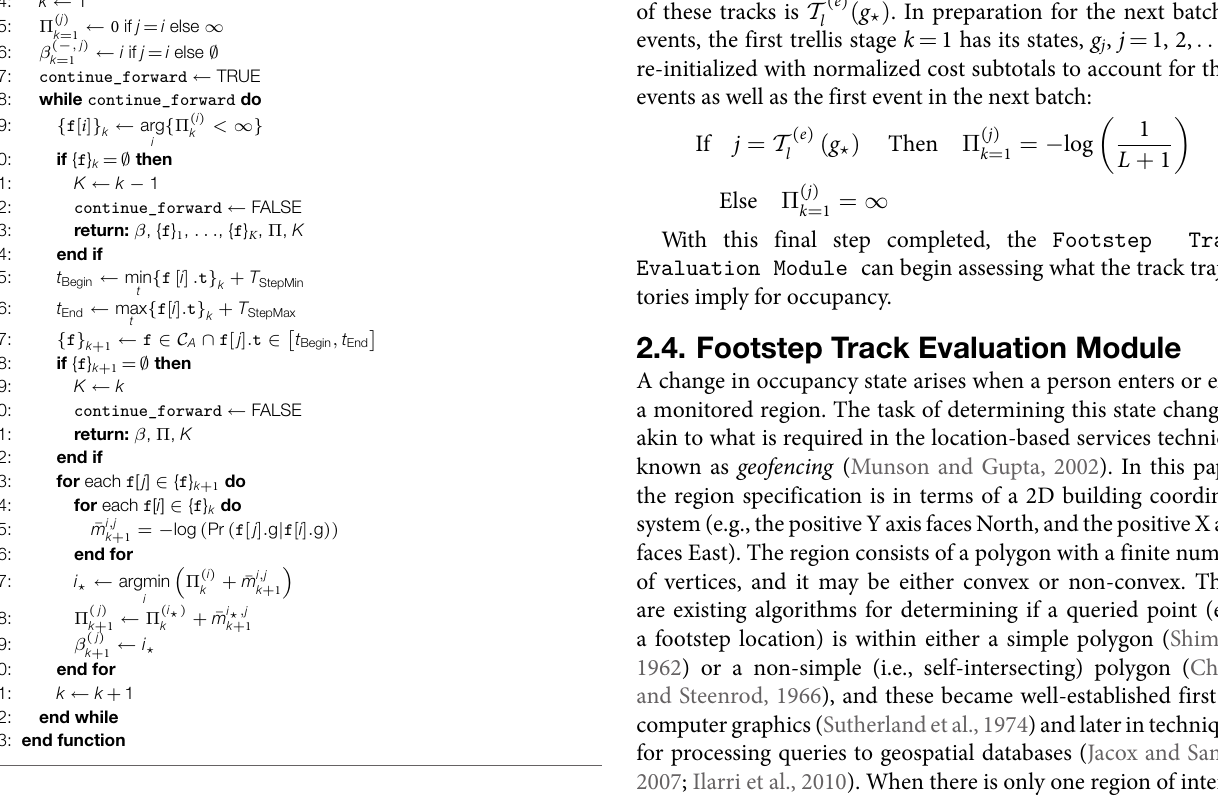
ALGORITHM 3 | Traceback Optimal Path In